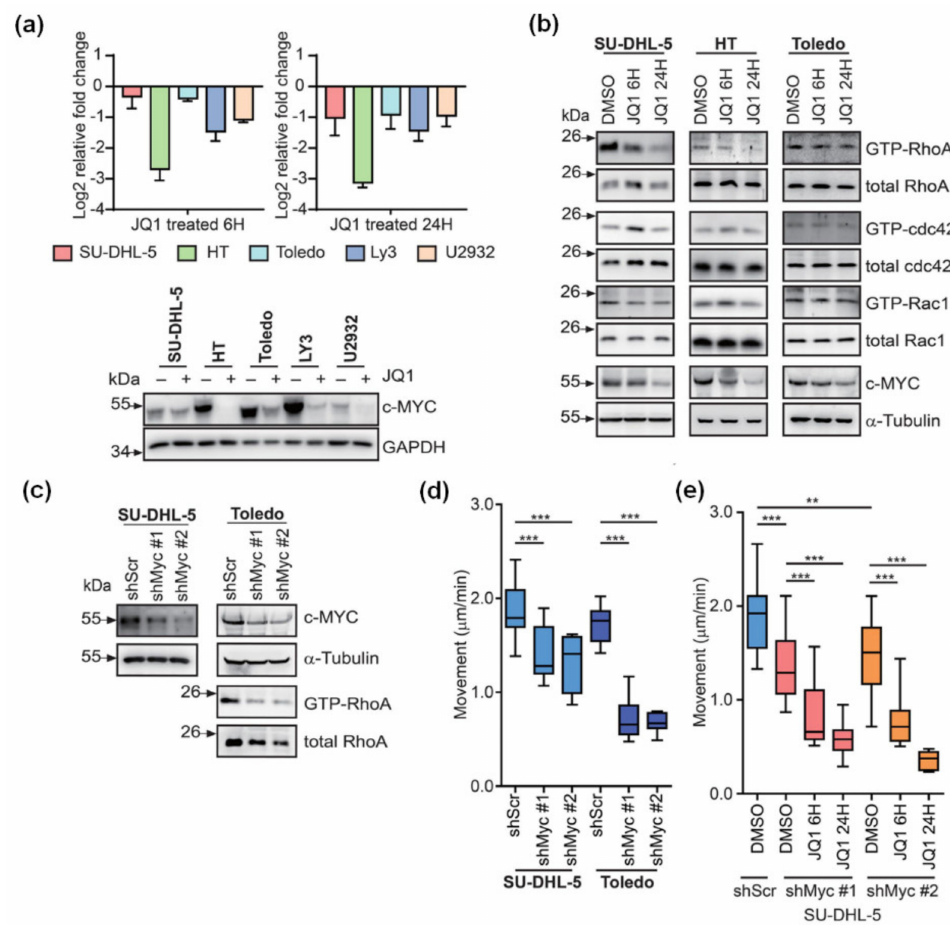
Figure 2. MYC suppression-mediated attenuated GTP-RhoA activity renders JQ1-treated DLBCL cells less mobile. ( a ) Measurement of the mRNA and protein expression levels of MYC in DLBCL cells treated with JQ1. Cells were incubated with 1 µ M of JQ1 for indicated time periods. The level of MYC mRNA was quantified by qPCR (upper panel, n = 3), whereas the c-MYC protein level was assessed by Western blotting after 24-hour incubation with JQ1 (lower panel; the Western blots were repeated thrice, and the representative data are shown). Folds of mRNA expression were obtained through calculating the ratios between treated samples and untreated controls. ( b ) Western blots on small GTPase activity assays. After treatment with either DMSO or JQ1 for indicated time periods, GTP-bound RhoA, Cdc42, and Rac1 in whole cell lysates from SU-DHL-5, HT, and Toledo cells were analyzed after GST pull-down capture. The experiments were repeated thrice, and the representative data are shown. ( c ) Western blots on c-MYC and GTP-bound RhoA in HT and Toledo cells receiving either shRNA specific to Myc (shMyc; clones #1 and #2) or a scramble sequence (shScr). ( d ) Quantification of movement speeds of shMyc- or scramble control-treated DLBCL cells ( n = 10). *** p < 0.001 by Student’s t -test. ( e ) Quantification of movement speeds of shMyc- or scramble control-treated HT cells in the presence of either DMSO or JQ1 for indicated time periods ( n = 10). ** p < 0.01, *** p < 0.001, by Student’s t